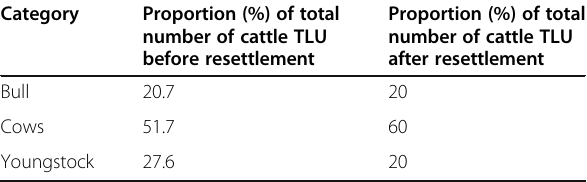
Table 3 Cattle herd structures before and after the resettlement Category Proportion (%) of total number of cattle TLU